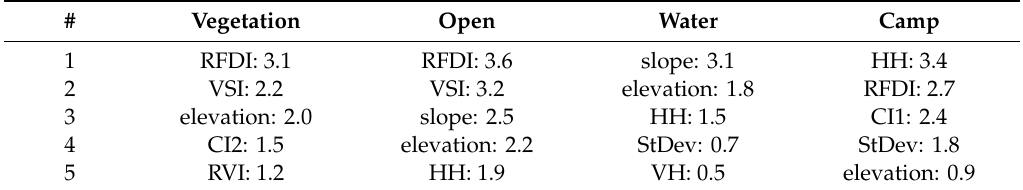
Table 5. The five most important features per class according to their permutation importance (PI) [%]. CI = combined index.